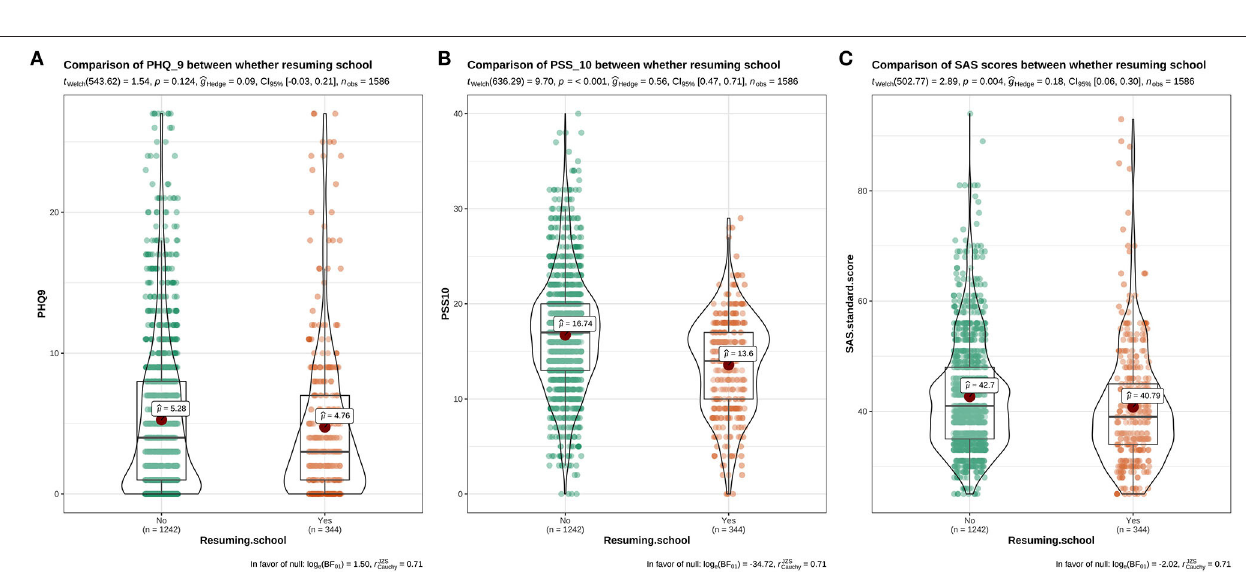
FIGURE 4 | The distribution maps of PHQ-9, PSS-10, and SAS scores in different majors. (A) Distribution of PHQ-9 scores in different majors; (B) Distribution of PSS-10 scores in different majors; (C) Distribution of SAS scores in different majors.